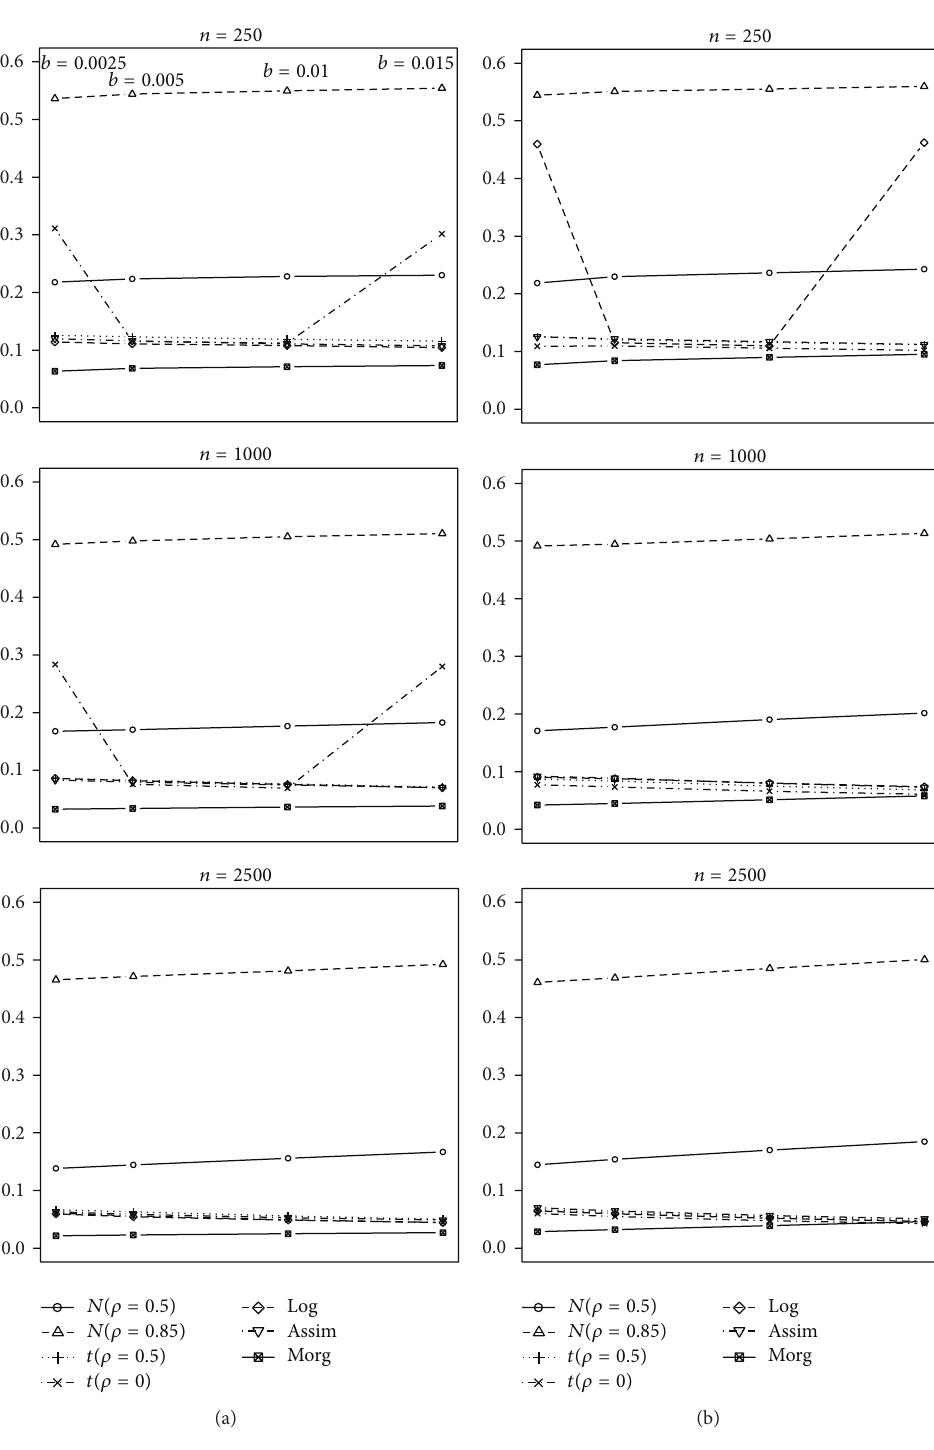
Figure 3: Root mean squared error (rmse) of estimator 𝑏 = 0.0025, 0.005, 0.01, 0.015 ,